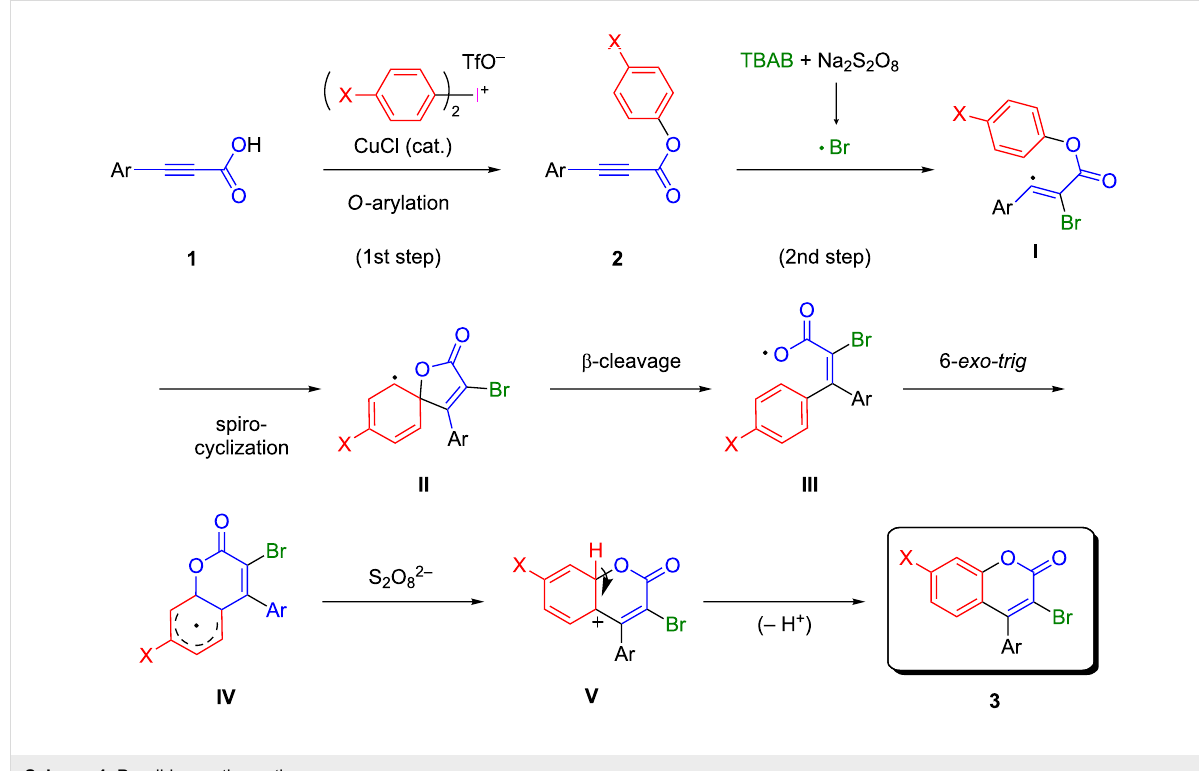
Scheme 4: Possible reaction pathway.